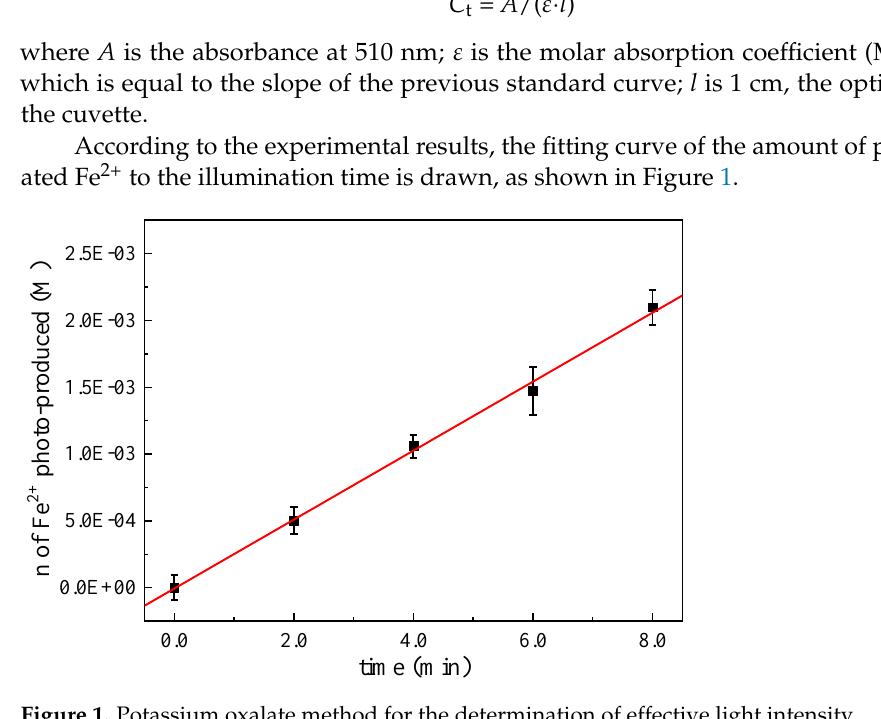
Figure 1. Potassium oxalate method for the determination of effective light intensity.